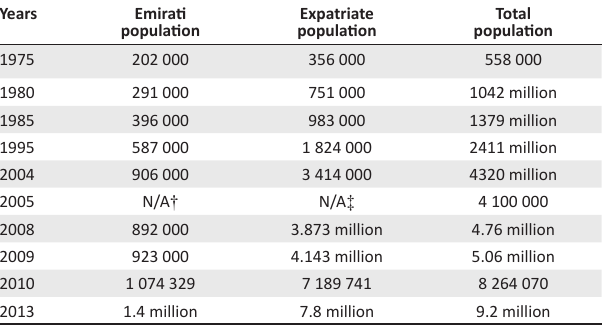
TABLE 1: Demographic changes in the UAE’s